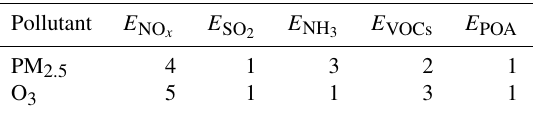
Table 1. Degree of variables in the polynomial function of response to emission changes.